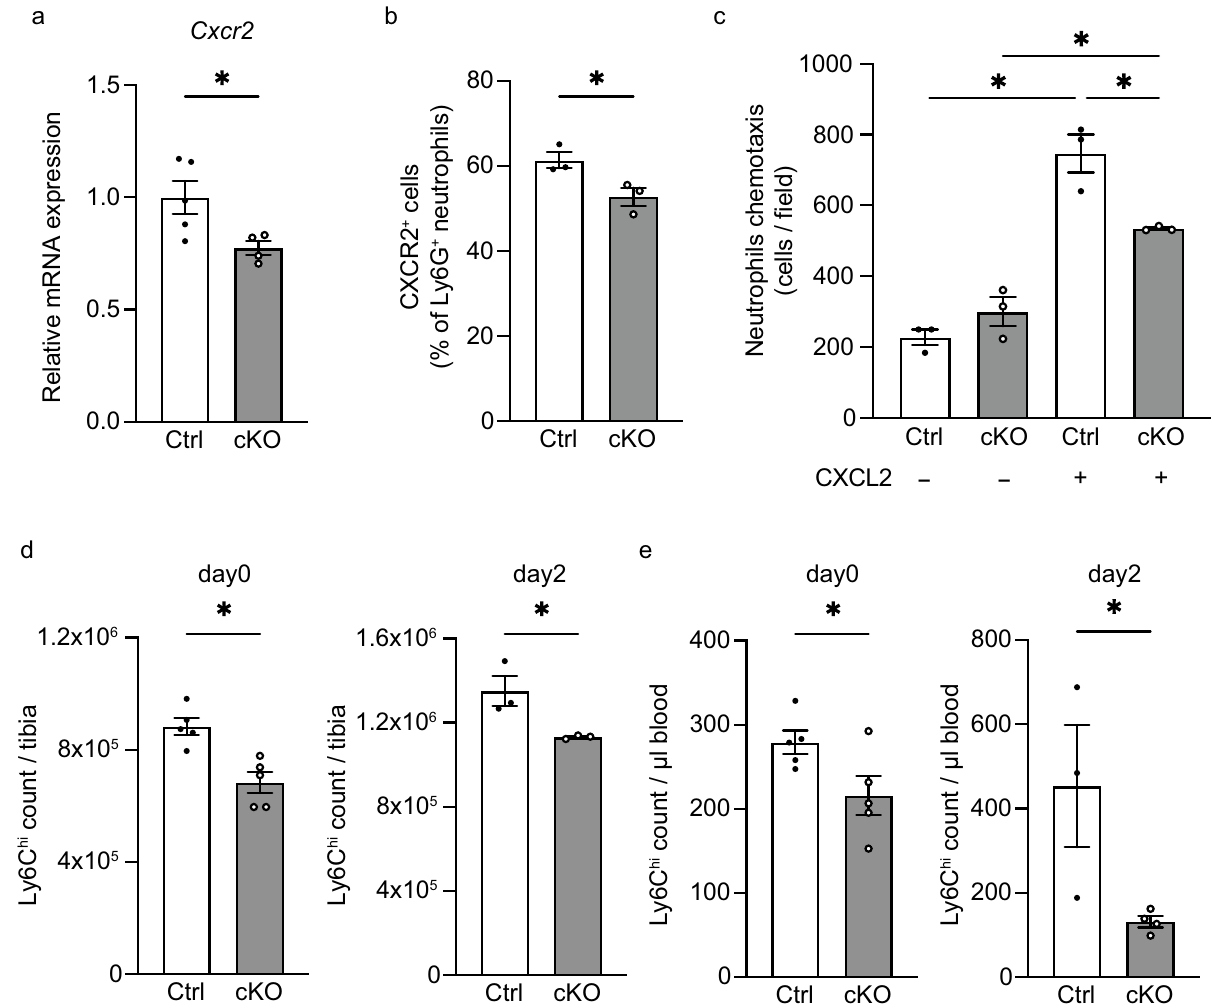
Figure 4. Arntl deletion from myeloid cells decreases expression of Cxcr2 related to neutrophil migration and reduces monocyte numbers in bone marrow and peripheral blood. ( a ) RT-PCR assessment of chemokine (C-X-C motif) receptor 2 ( Cxcr2 ) expression in neutrophils (CD45 + CD11b + Ly6G + ) sorted from untreated bone marrow cells from Ctrl (n = 5) and cKO (n = 4) mice. ( b ) Percentage of CXCR2 + cells among Ctrl (n = 3) and cKO (n = 3) bone marrow CD45 + CD11b + Ly6G + neutrophils. ( c ) Numbers per field of migrated Ctrl (n = 3) and cKO (n = 3) neutrophils left untreated or stimulated with 100 ng/ml CXCL2. ( d) Quantification of monocytes (CD45 + CD11b + Ly6G - Siglec-F - Ly6C hi ) among control (Ctrl) and cKO bone marrow cells from mice left untreated (n = 5) and on day 2 after muscle injury (n = 3). ( e ) Quantification of monocytes in peripheral blood from Ctrl and cKO mice left untreated (n = 5) and on day 2 after muscle injury (n = 3). Data are expressed as the means ± SEM. * p < 0.05 with unpaired two-tailed Student’s t -test ( a , b , d , e ) or two-way ANOVA with Bonferroni’s multiple comparisons test ( c